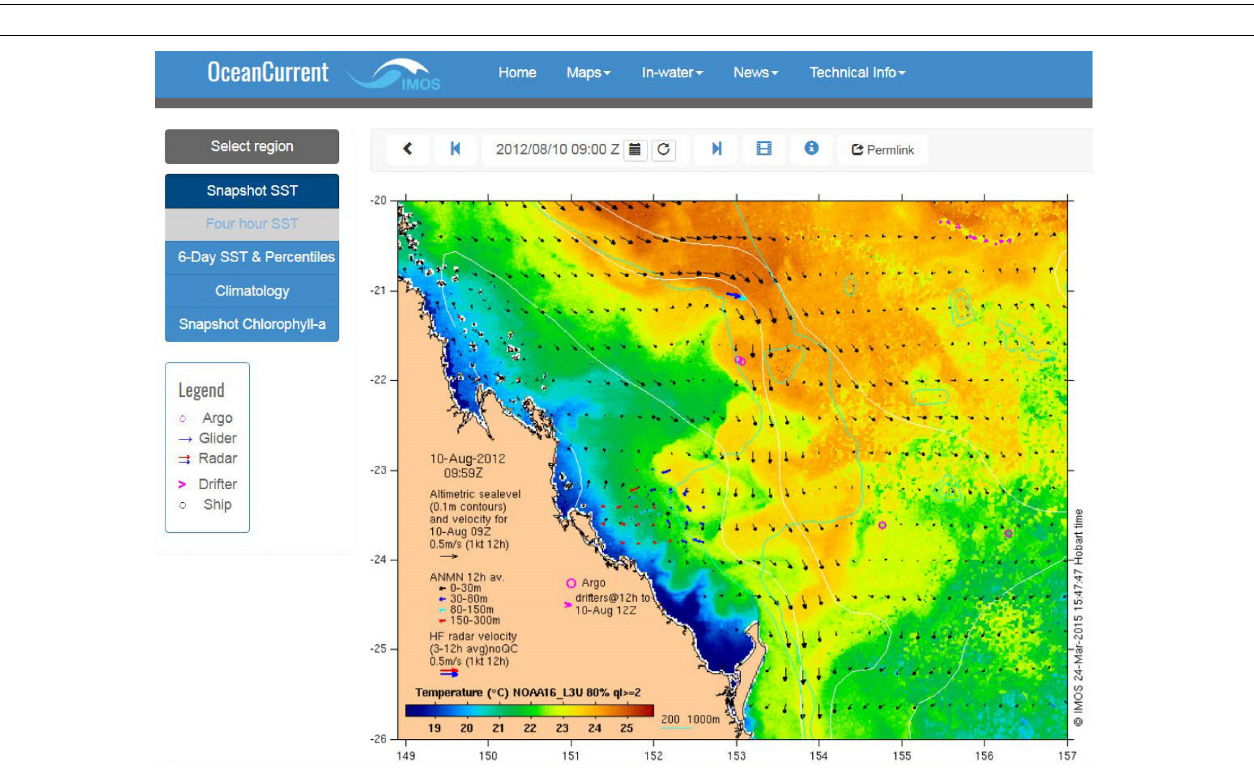
FIGURE 11 | NOAA Wave Watch 3 wave height (modeled), and High Frequency Radar surface currents data (observed) produced by MARACOOS, alongside real-time NDBC data (observed) from coastal moorings (purple markers). This product enables time-series comparisons at the coastal mooring location between modeled and observed variables. Source: MARACOOS (http://oceansmap.maracoos.org).